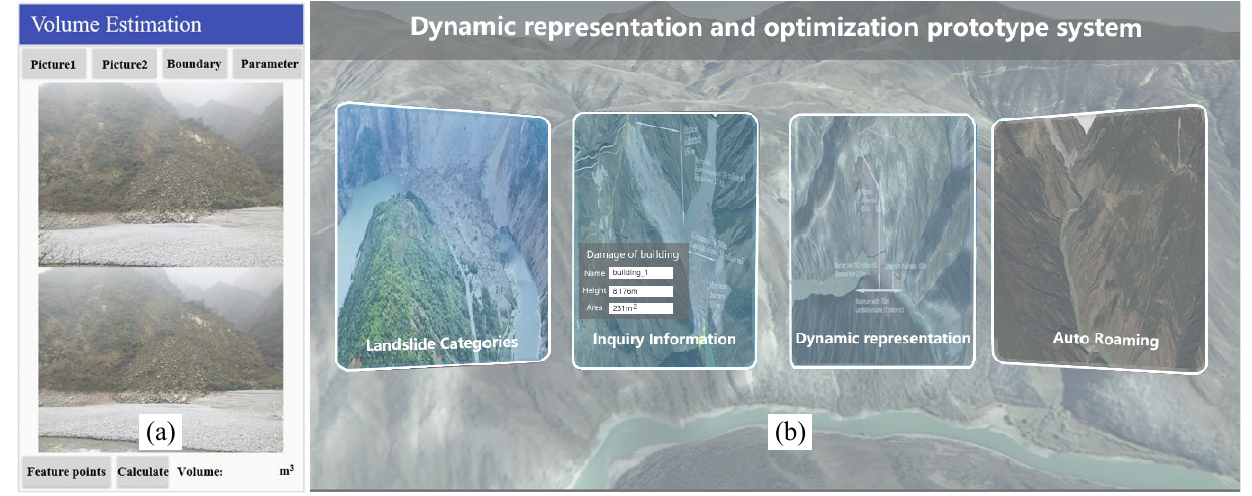
Figure 4. Prototype system interface. ( a ) Volume estimation, ( b ) disaster scene visualization and optimization.